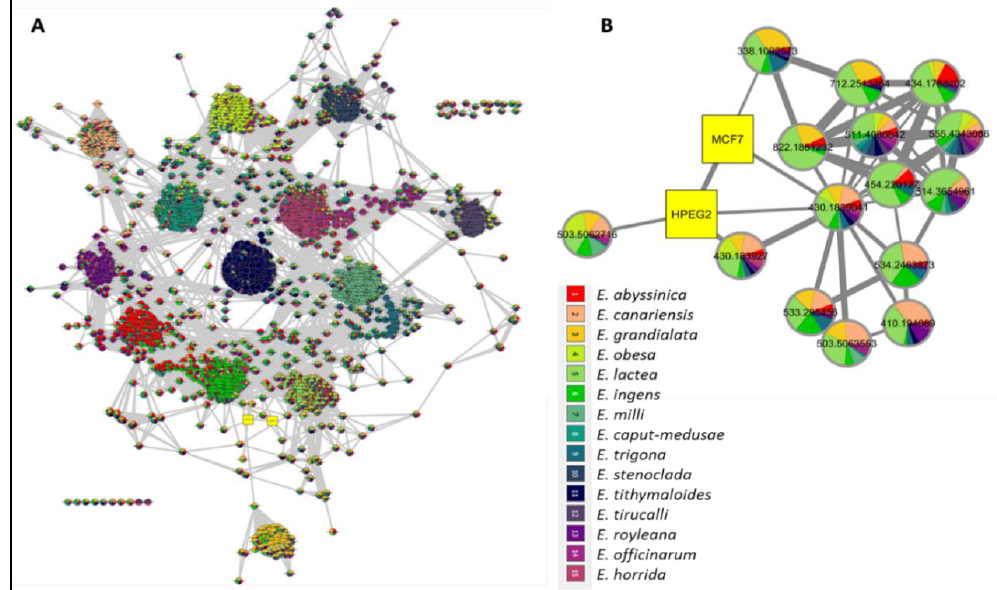
Figure 4. ( A ): OPLS-DA score plot showing a clear separation between ( • ) CACO2 cytotoxic extracts and ( • ) inactive ones, ( B ): S-loading plot showing the metabolites highly correlated with CACO2